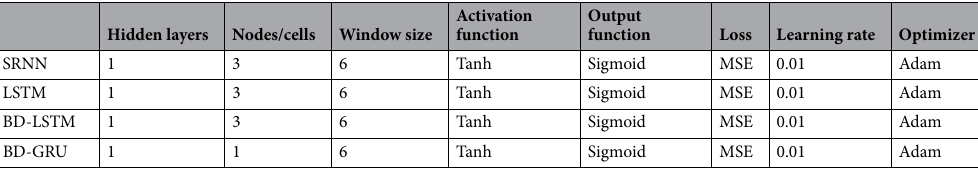
Table 1. Optimal parameters used for the different RNN